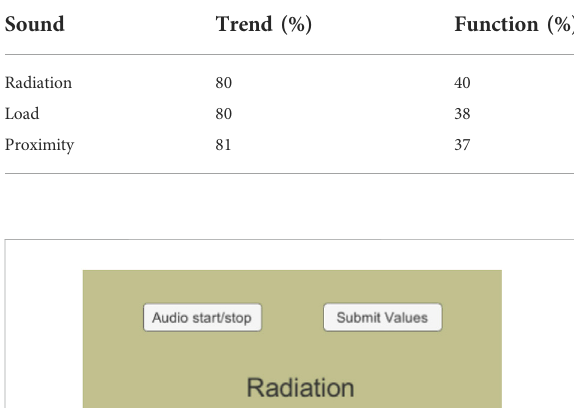
TABLE 2 Table showing the proportion of participants correctly identifying the trend and speci fi c function from the abstract sounds.